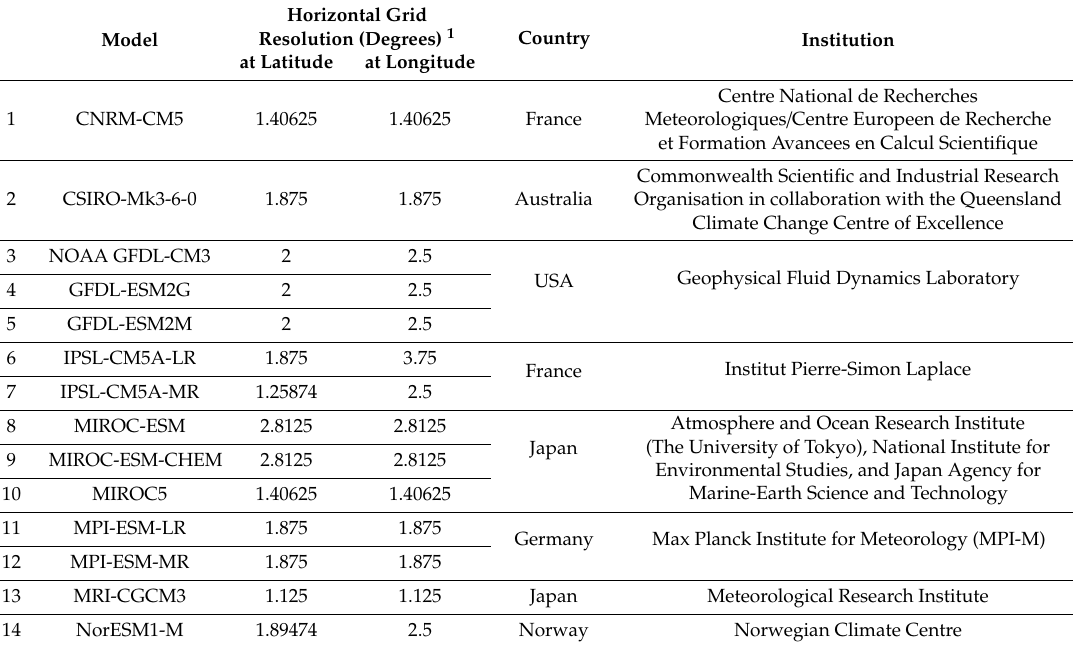
Figure 3. Areas of reanalysis and climate models data averaging. Red rectangle marks CALM sites location. Table 2. The list of used climate models CMIP5 and its major parameters.